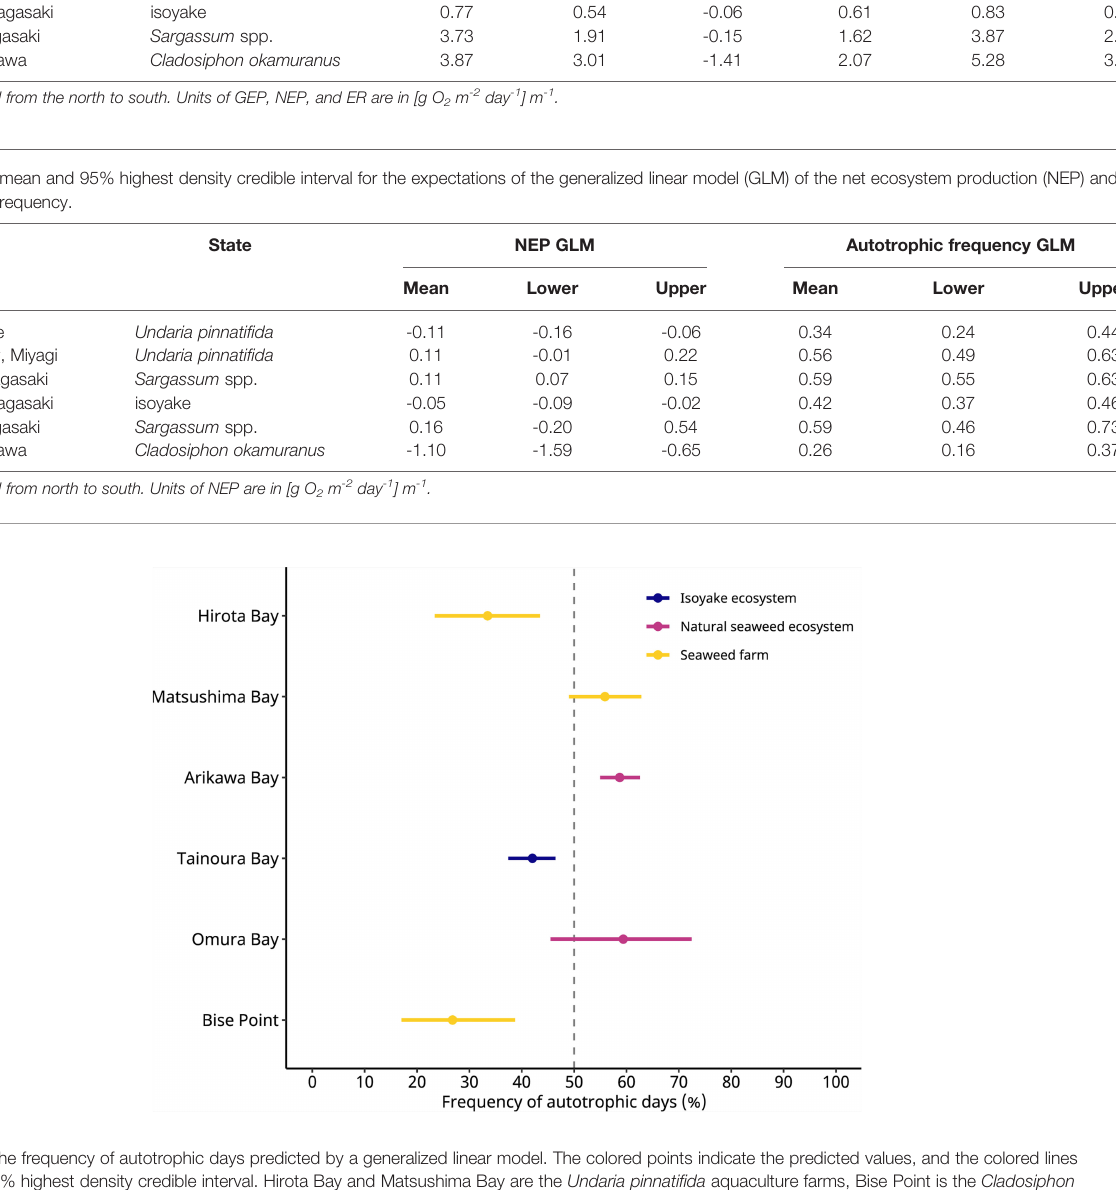
Rows are ordered from the north to south. Units of GEP, NEP, and ER are in [g O 2 m -2 day -1 ] m -1 .